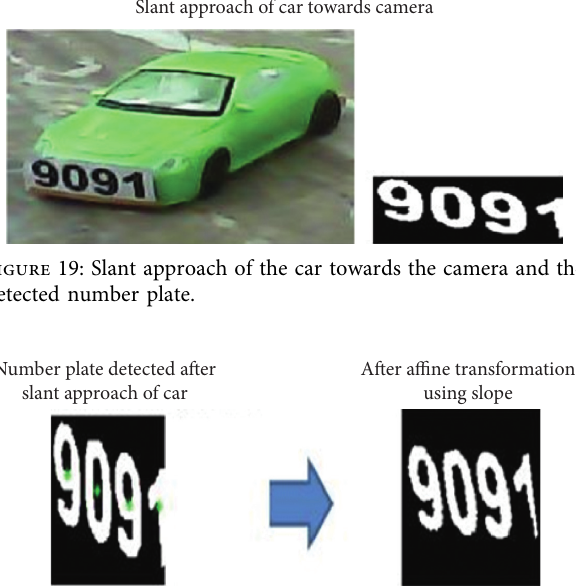
Figure 20: Result after affine rotation.